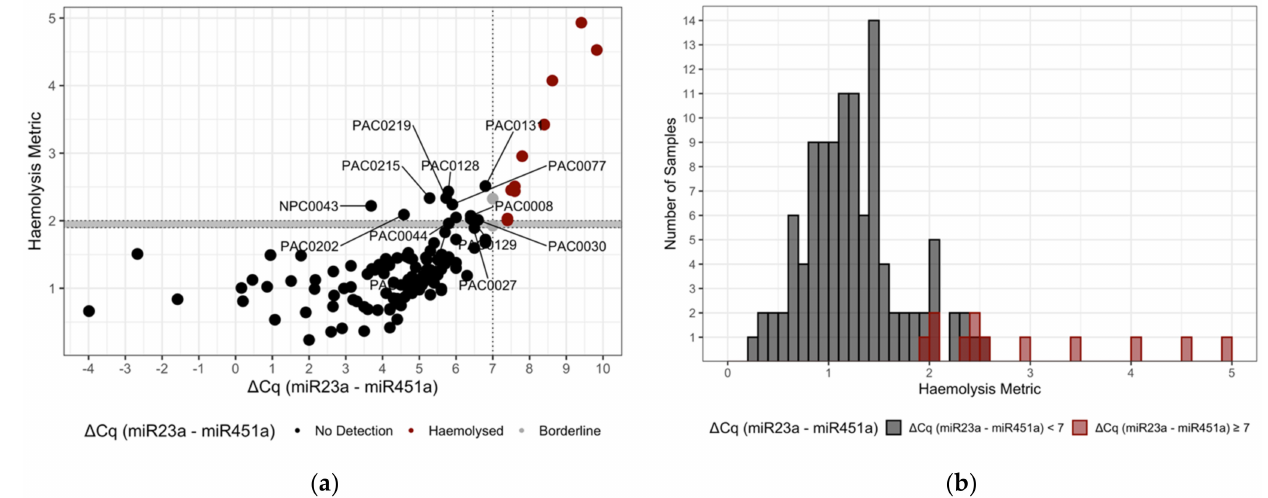
Figure 2. ( a ) A comparison of the derived haemolysis metric and the ∆ Cq measure of haemolysis shows a clear correlation. We identified 13 samples (named) that we suggest should be discarded or used with caution in further analysis. ( b ) Histogram of haemolysis metric values from the 121 samples in our experiment, coloured according to their ∆ Cq (miR-23a-3p-miR-451a) classification, indicate a minimum haemolysis metric of ≥ 1.9 for samples previously identified as